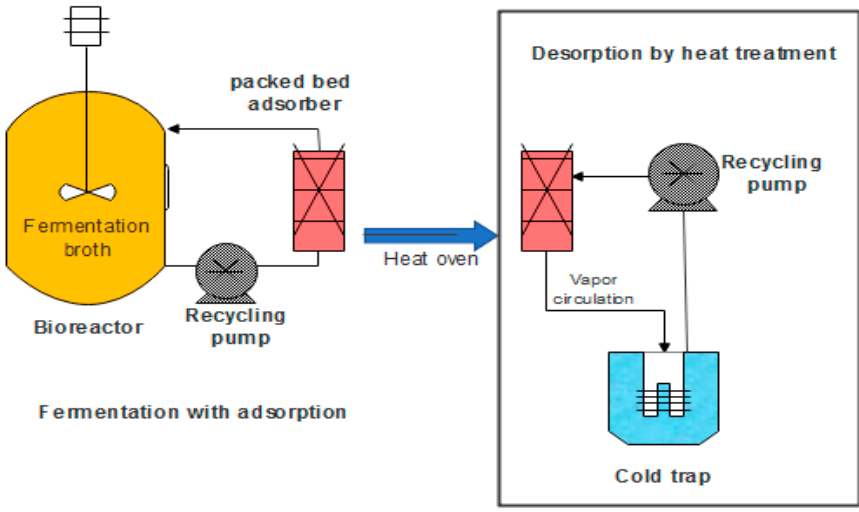
Figure 5. Diagram of the continuous fermentation with adsorption unit for ethanol separation.